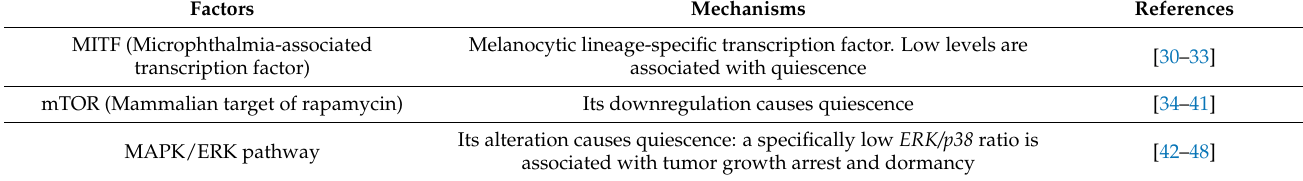
Table 1. Main factors involved in melanoma